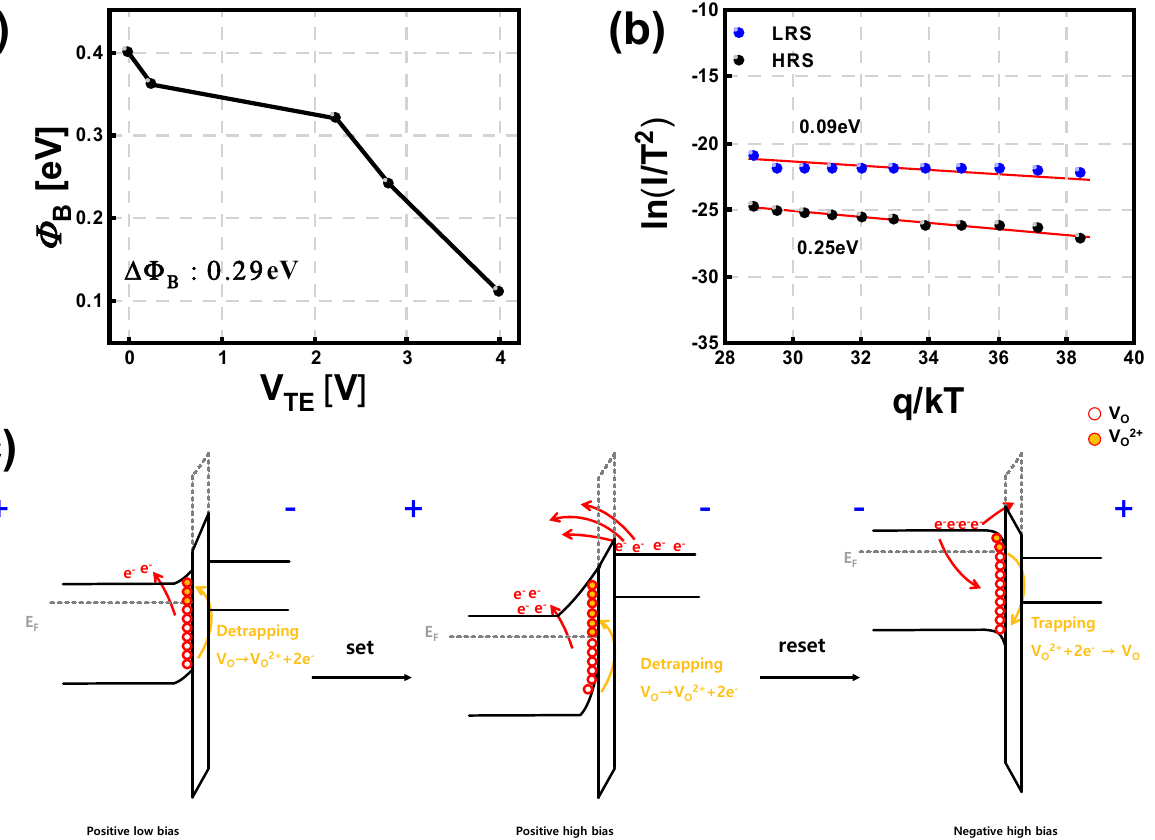
Figure 5. ( a ) ϕ B of S2 according to the applied voltage. ( b ) Arrhenius plot of I / T 2 for S2 to extract ϕ B . ( c ) Energy band diagrams of S2 during the set and reset operation.